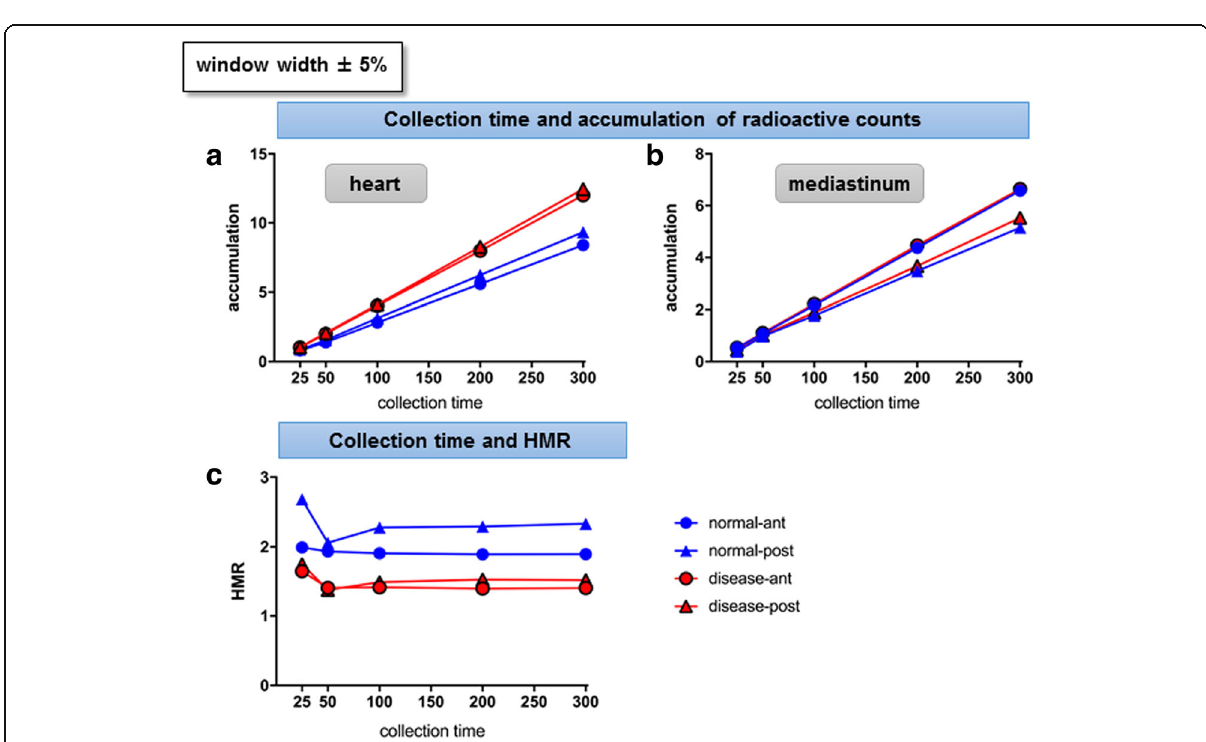
Fig. 3 Changes in parameters at different collection times (phantom study). With the window width fixed at ± 5%, the relationship between different collection times ( x -axis) and radioactive counts in the ROIs on the heart ( a ) and mediastinum ( b ), HMR ( c ), are shown. The meanings of the markers are the same as indicated in Fig.